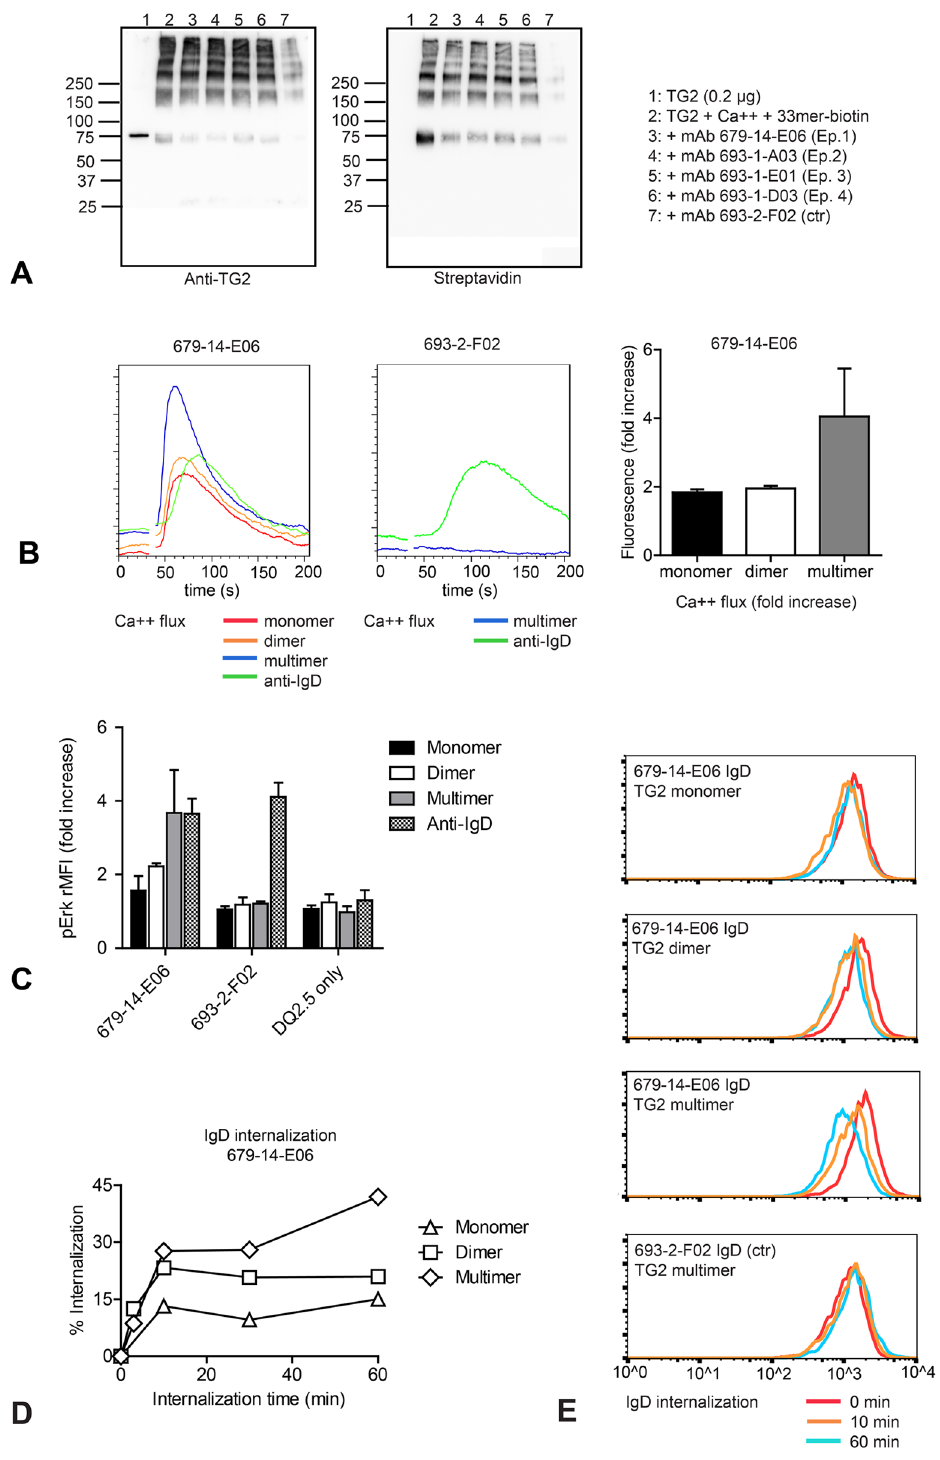
Fig 5. TG2 multimers are superior to TG2 monomer in activation of TG2-specific A20 B cells (A) Celiac TG2-specific monoconal antibodies are able to bind TG2-gluten multimer complexes. TG2 crosslinked in the presence of biotin-33mer peptide was immunoprecipitated using TG2-specific monoclonal antibodies representing all four celiac epitopes, or using a non TG2-specific monoclonal antibody (693-2-F02). TG2 was detected with mouse monoclonal antibody CUB7402 and TG2-bound peptide was detected with HRP-